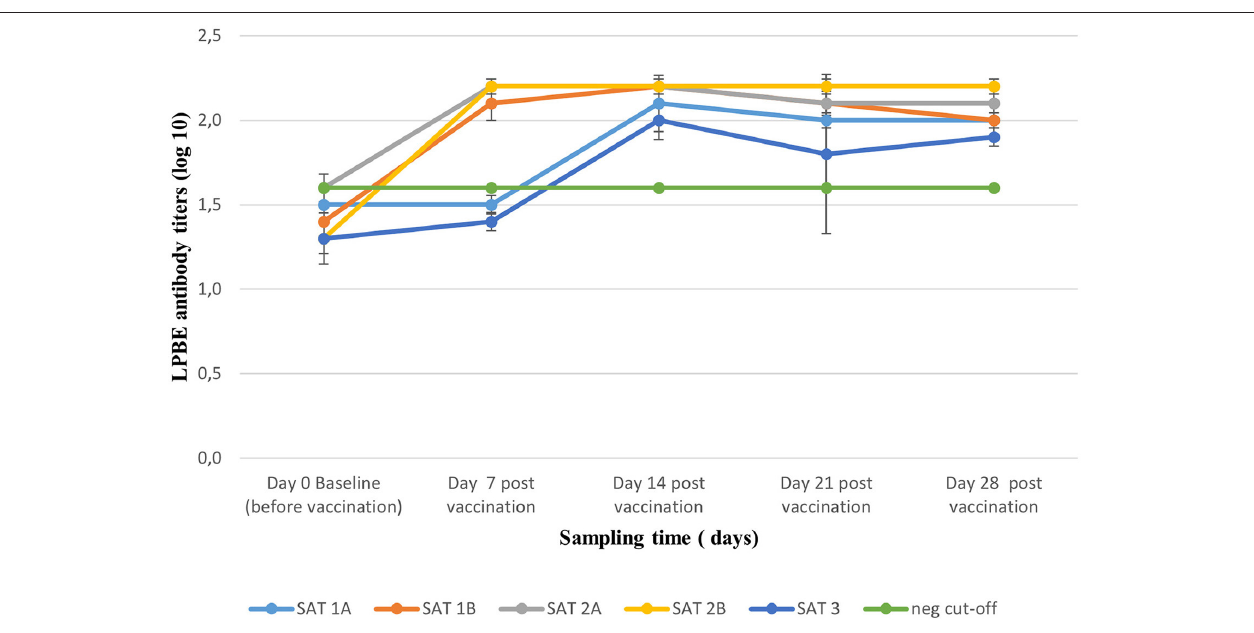
Frontiers in Veterinary Science |